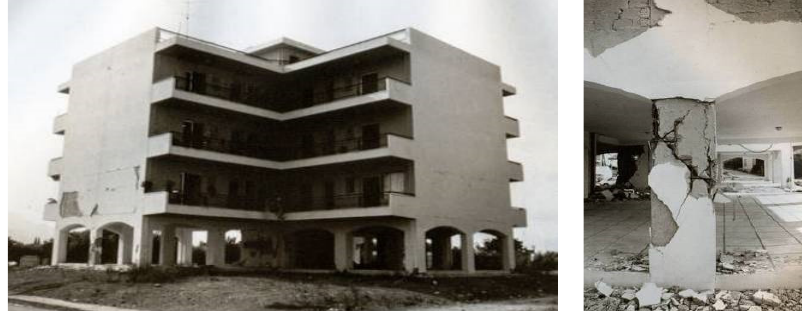
Figure 1. Damaged columns at the soft story.